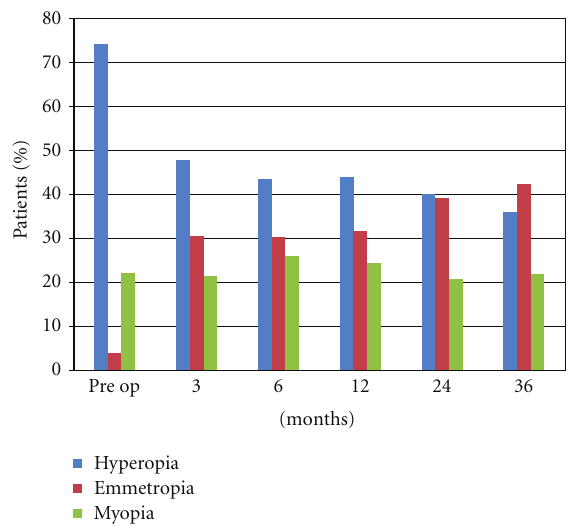
Figure 2: Spherical equivalent in pre-op and in di ff erent periods of